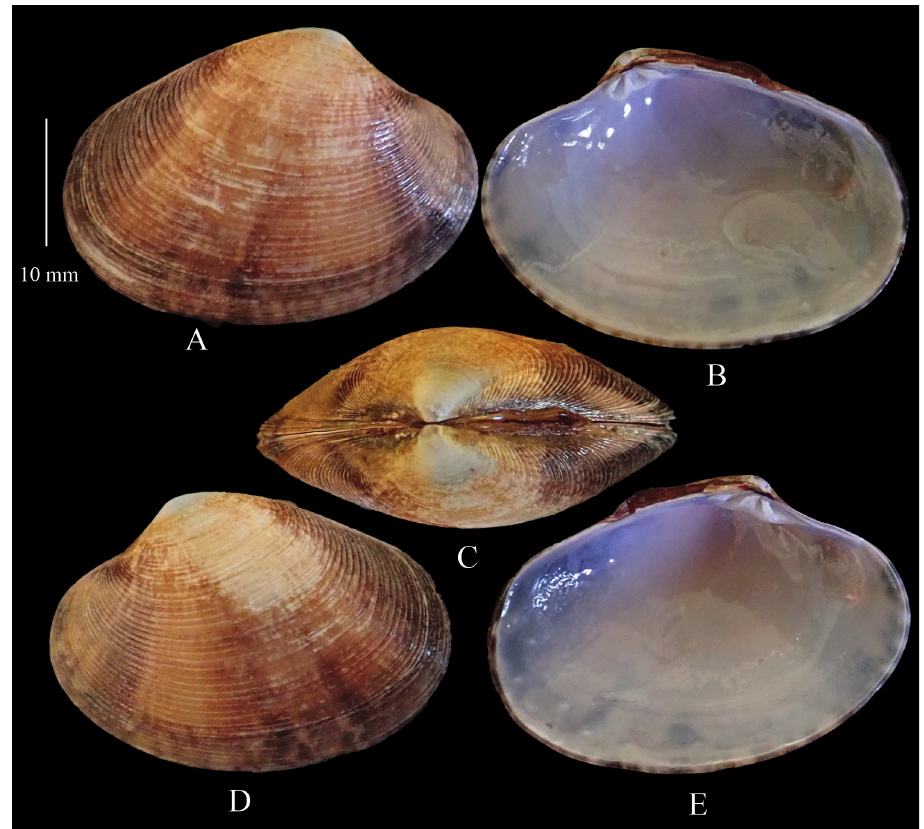
Figure 5. Marcia recens Morphotype 1 A right valve dorsal B right valve ventral C dorsal margin D left valve dorsal E left valve ventral (DABFUK), Ashtamudi Lake,